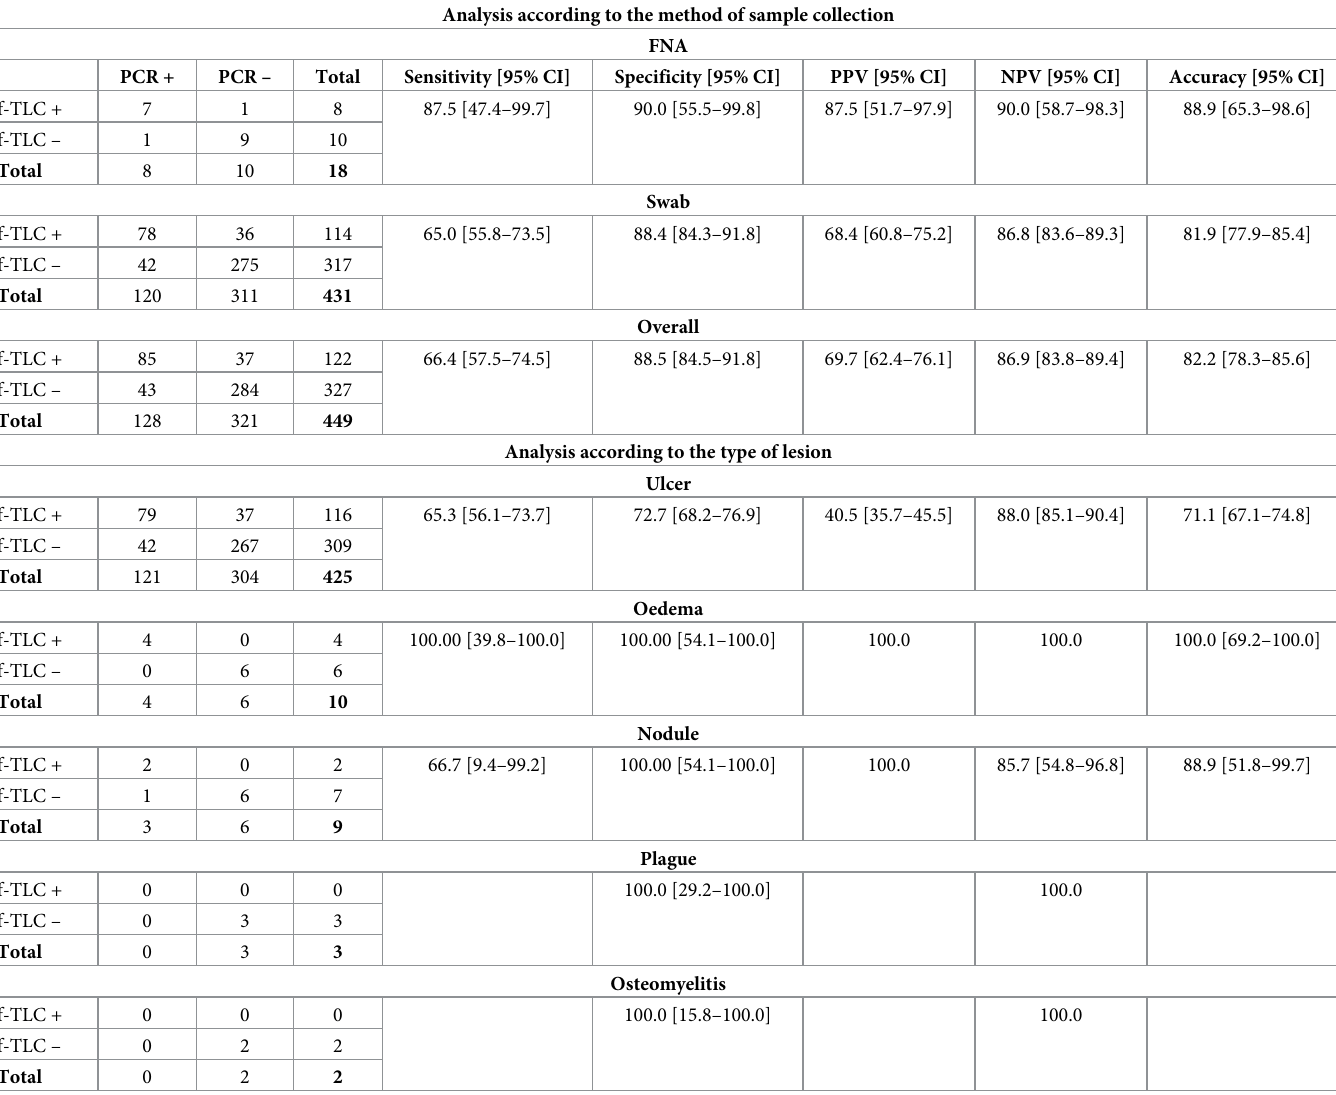
Table 3. Sensitivity, specificity, PPV, NPV, and accuracy of f-TLC compared to PCR according to sample type.